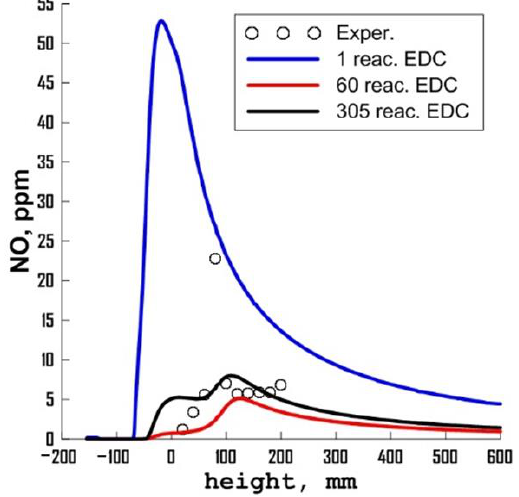
Figure 21. Distribution of temperature and gas composition along the burner axis in the experiment and the calculation for various mechanisms of chemical kinetics.